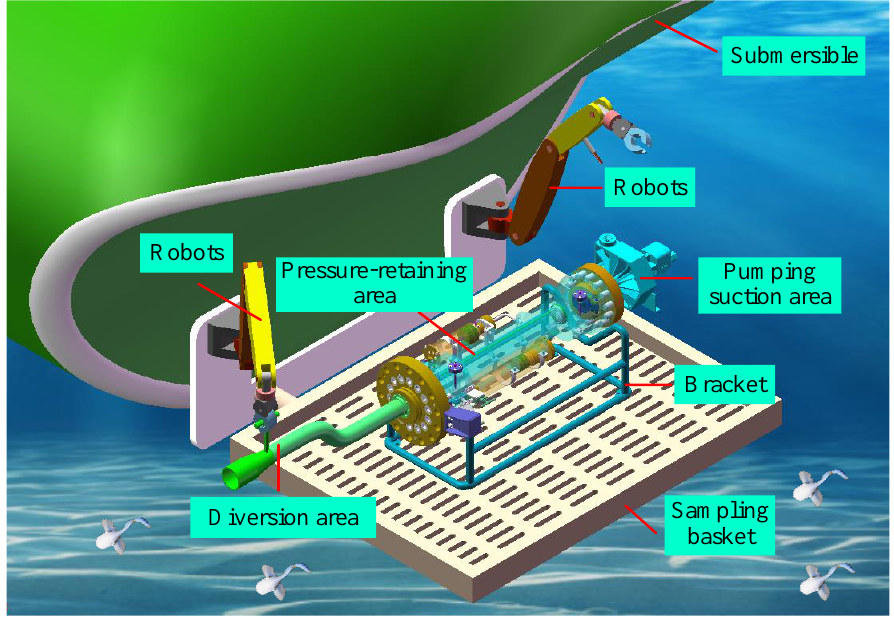
Figure 1. HSMPS onboard the submersible.